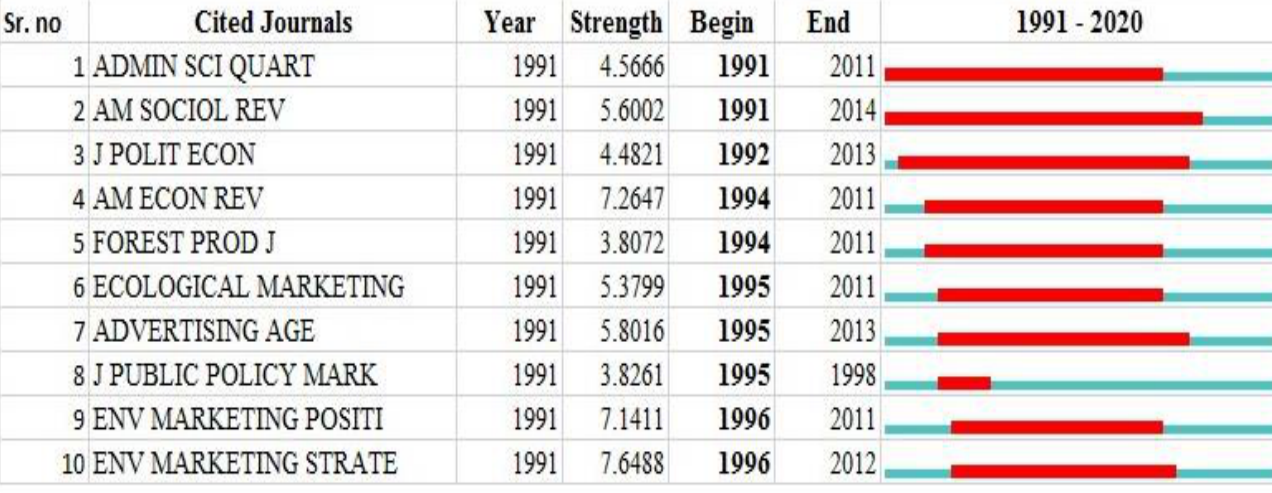
Figure 4. Top 10 cited journals with the strongest citation bursts.